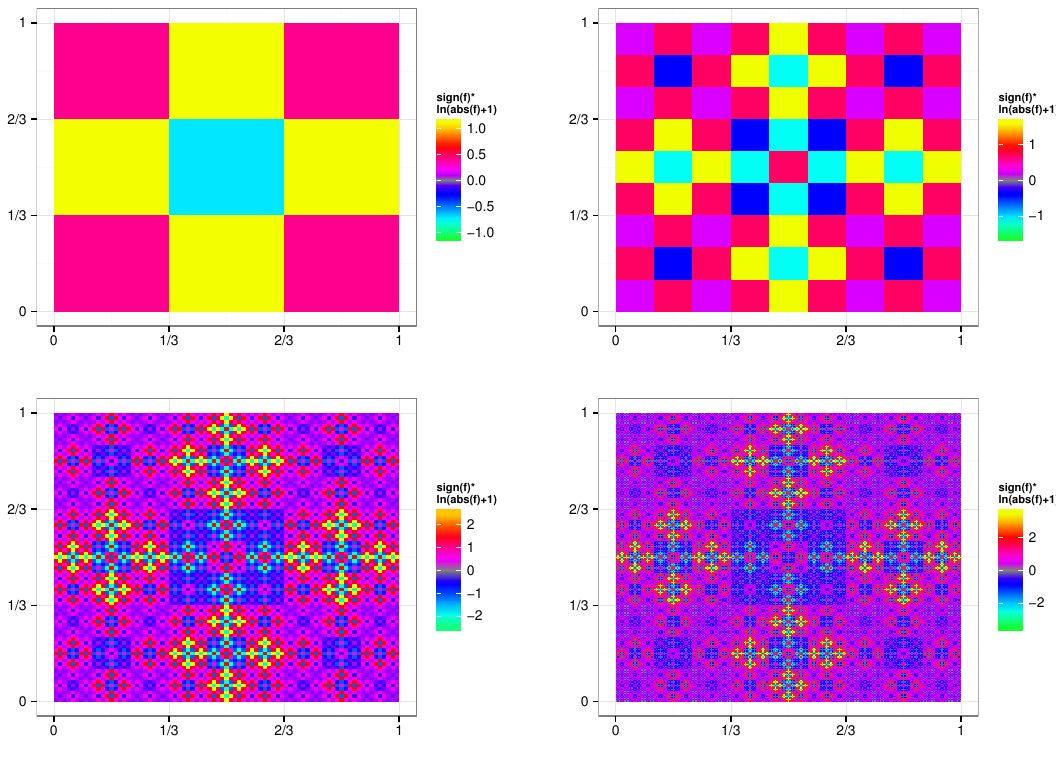
( Π ) , with τ 2 according to Example 2.2 and n ∈ { 1, 2, 4, 6 Figure 2: Density f of W n τ 2